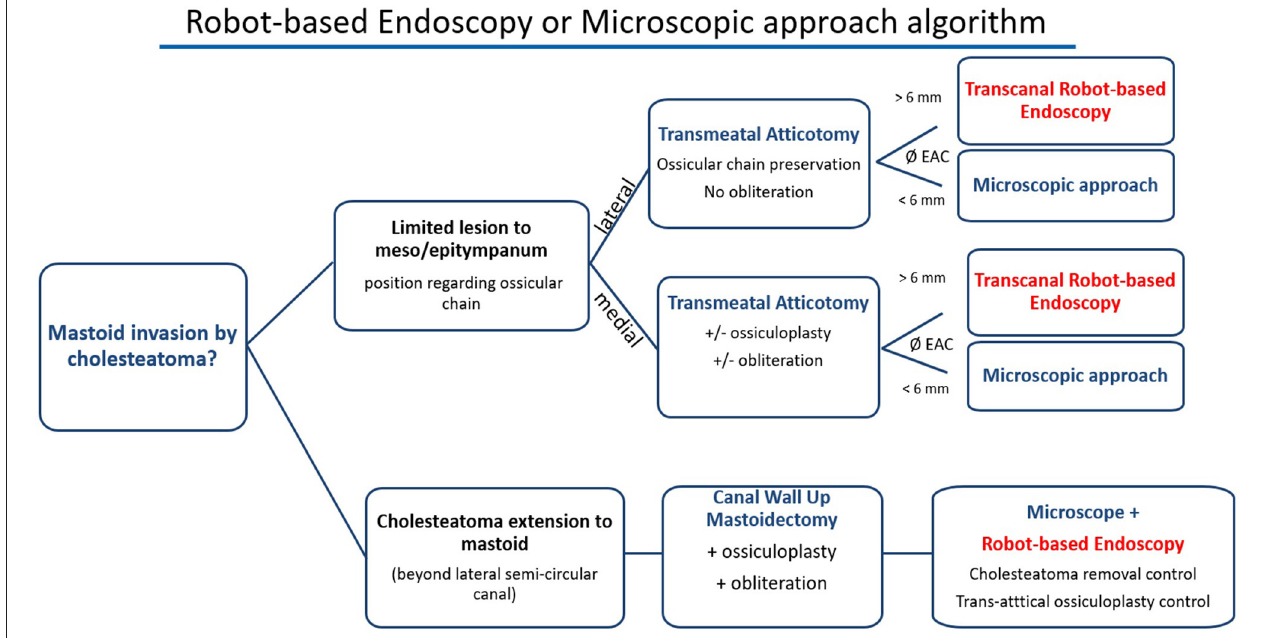
FIGURE 5 | Proposed algorithm for robot-based endoscopy indication. Robot-based endoscopy should be used as an additional tool to the microscope and not as a competing device. Its main limitation is the external auditory canal (EAC) diameter that may limit the use of two tools and the endoscope. We propose the following decision tree to choose the use of the robot-based endoscopy, the microscope and both to perform the approach and surgery.